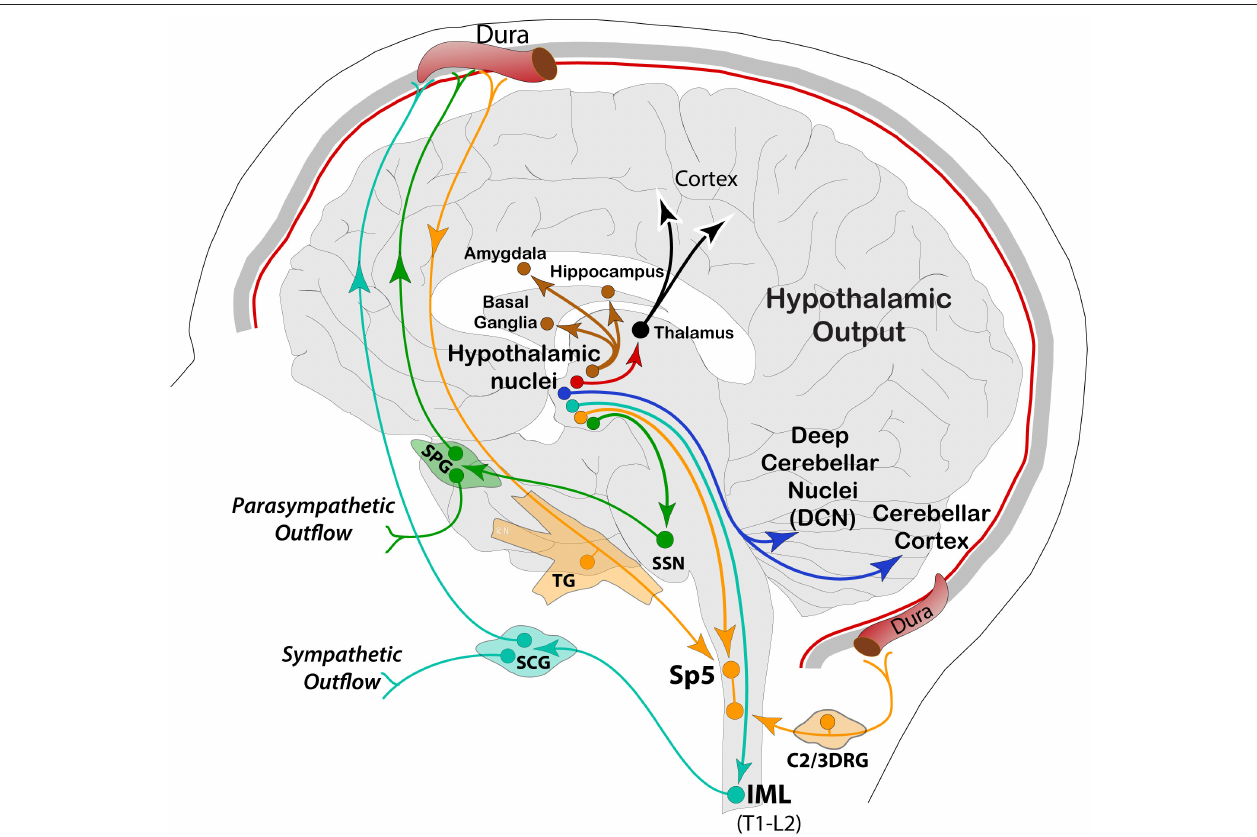
FIGURE 2 | Schematic representation of hypothalamic efferent pathways to autonomic (SSN, intermediolateral, IML), trigeminal (Sp5), cerebellar (DCN and cortex), thalamic and other forebrain areas associated with motor, sensory, cognitive, and affective functions. SPG, sphenopalatine ganglion; SCG, superior cervical